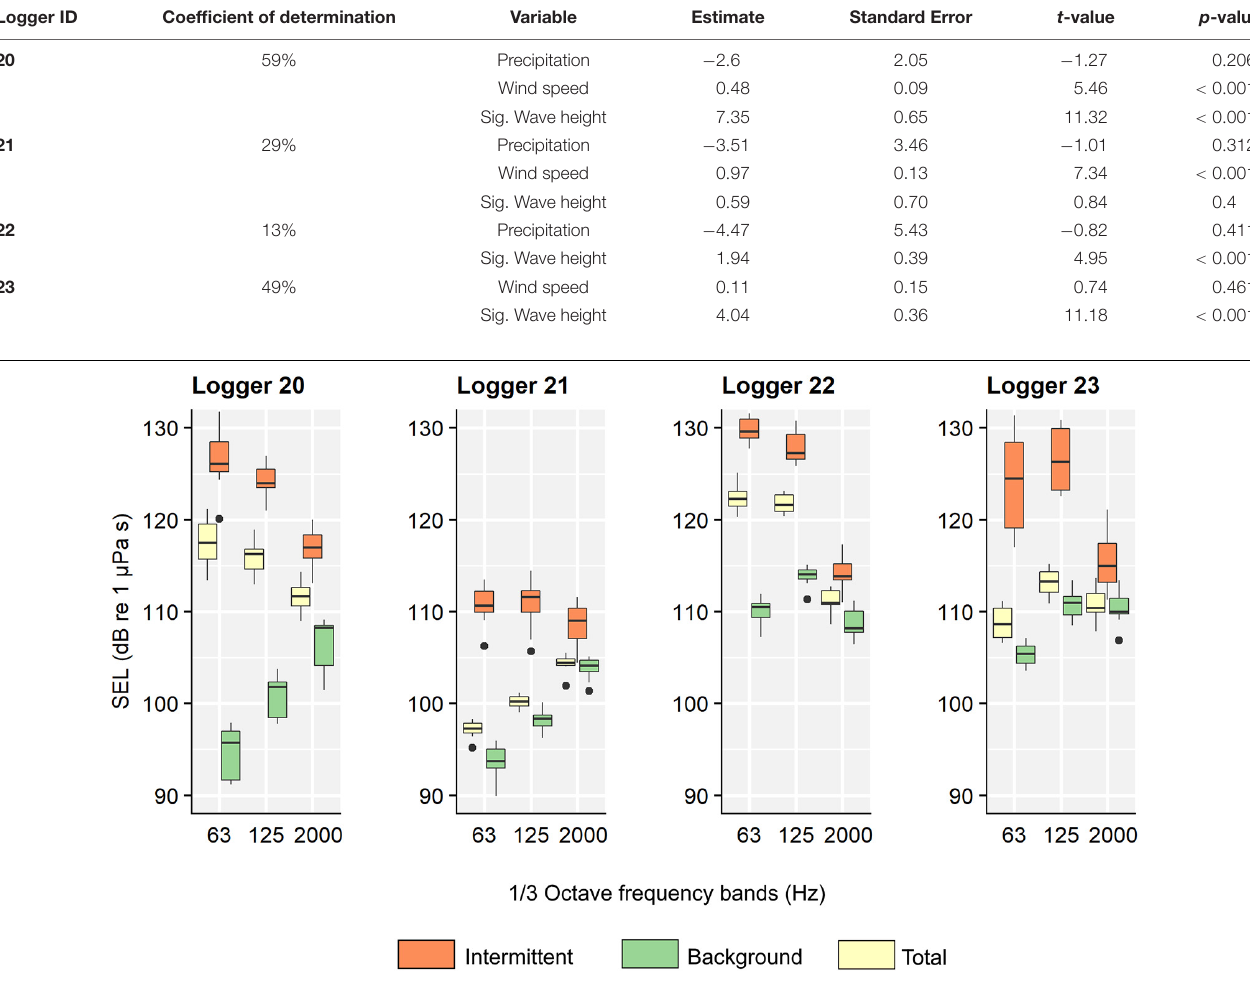
FIGURE 7 | Distributions of the 24-h sound exposure level (SEL) in three 1/3 octave bands with center frequencies of 63, 125, and 2000 Hz. Loggers 20, 21, 22, and 23 are described in the total (yellow), intermittent (orange), and background (green) 24-h SEL distributions. The solid black line represents a median and the colored box a middle 50% of the values. Whiskers represent the range of all the data and black dots the